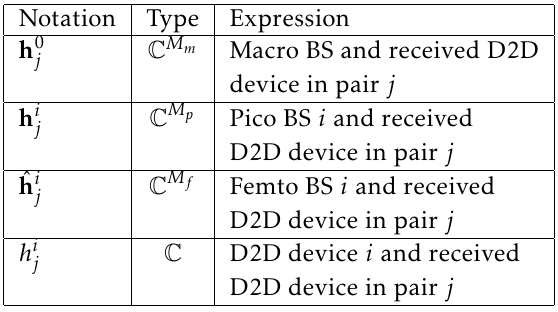
Table 1. Propagation channels in the considered system